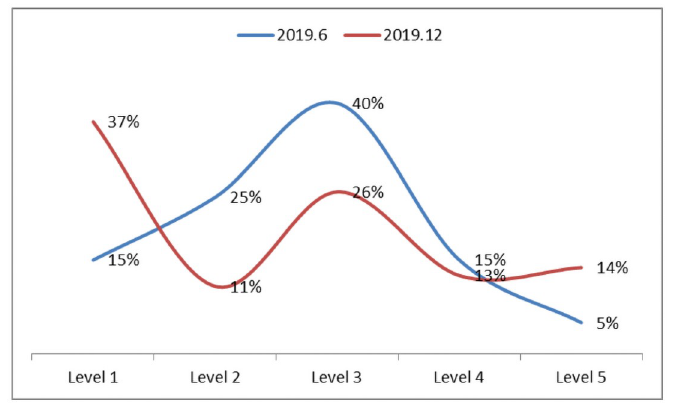
Fig 7. Ratio of the number of ranks (2019.12).